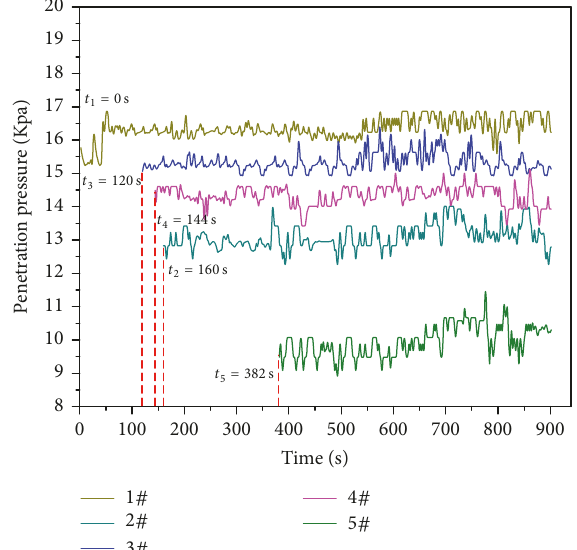
Figure 2: The change of penetration pressure over time from monitoring points 1#–5#.